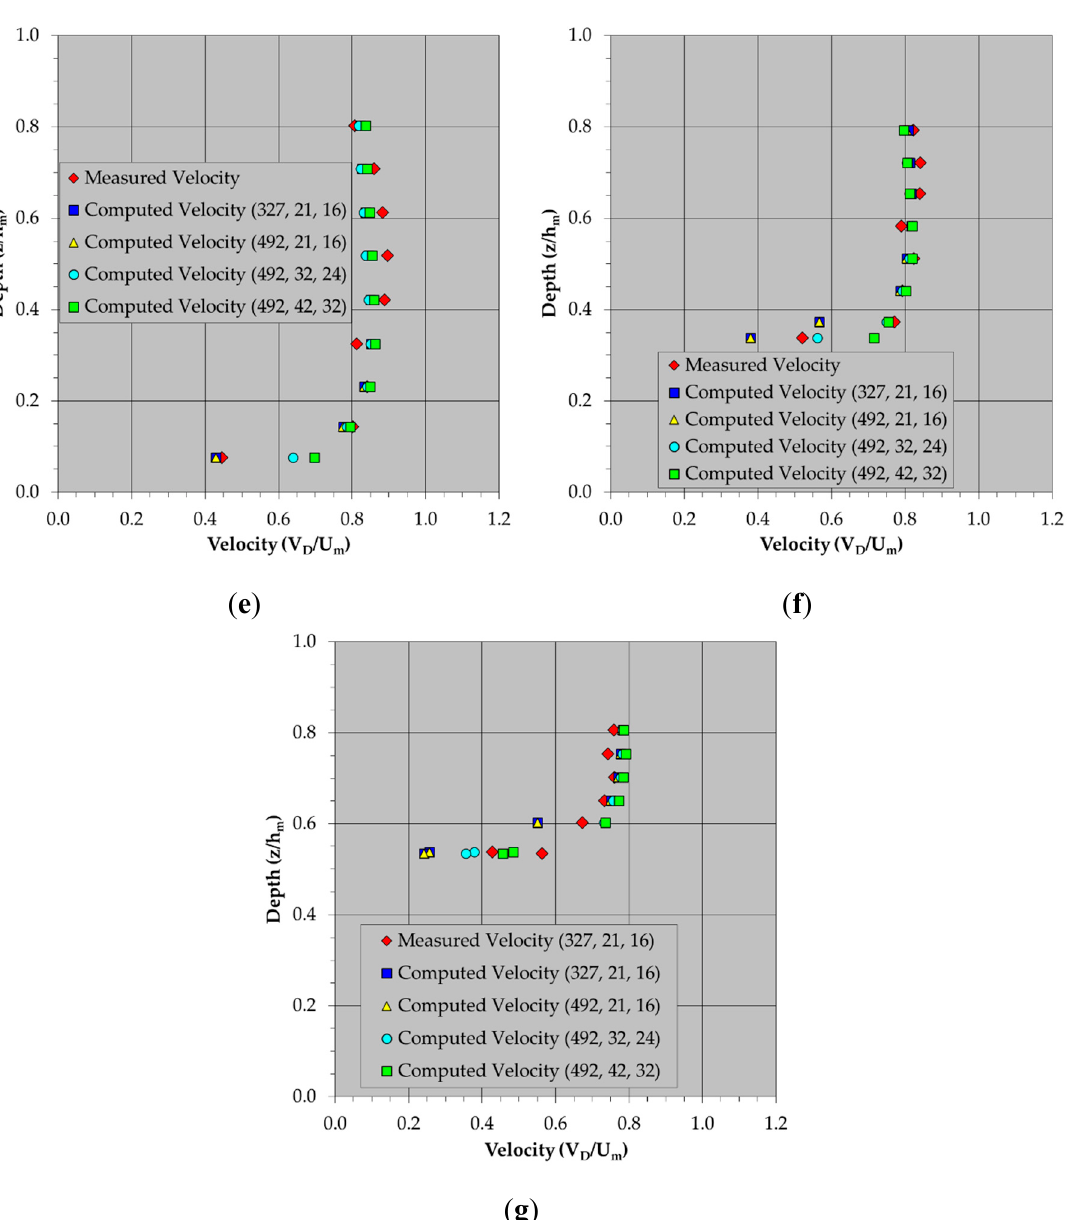
Figure A15. Comparisons of simulated and measured stream-wise velocity profiles using four different mesh sizes at Cross-section 10, located at the downstream end of the straight transition reach (profile measurement locations ( a – g ) are positioned left to right looking downstream).